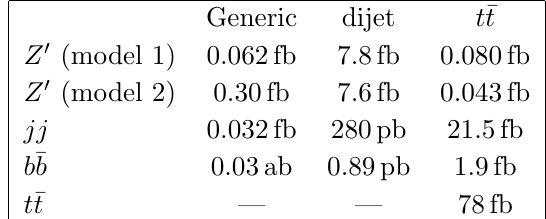
Figure 8 . Invariant mass distribution for the Z 0 signals in scenario 3 and their backgrounds, in the generic (top) and dijet (bottom) analyses, for model 1 (left) and model 2 (right).